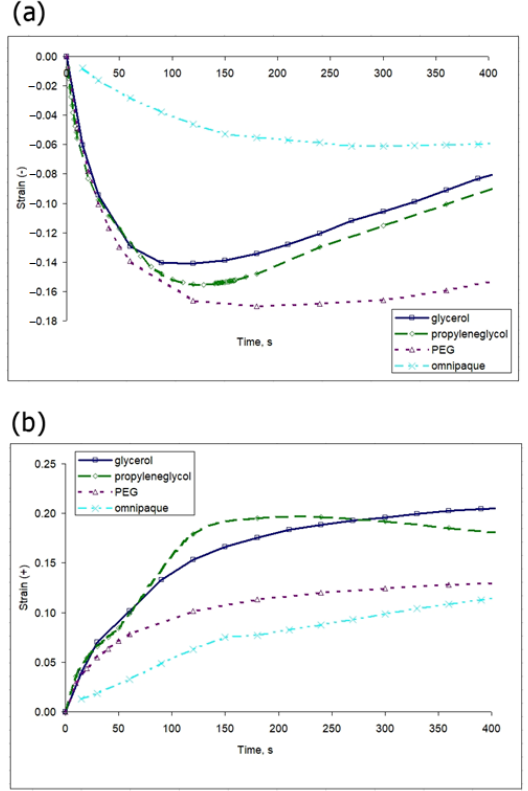
Figure 8. Quantitative analysis of positive ‐ signed strain kinetics induced in cartilage by the action of ( a ) glycerol, ( b ) PG and ( c ) PEG ‐ 400 with various concentrations. The upper images show the kinetic curves of strain evolution. The lower images show the corresponding dependencies of strain maxima on the agent concentration.